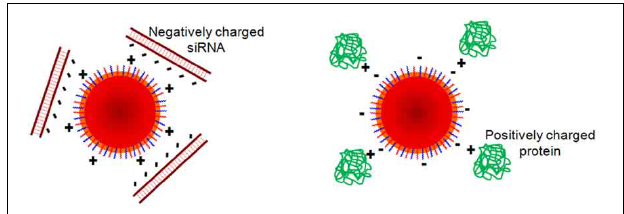
FIGURE 12 | Ionic coupling. Coupling of negatively charged siRNA (left) and of positively charged proteins (right) to negatively or positively charged AuNPs.